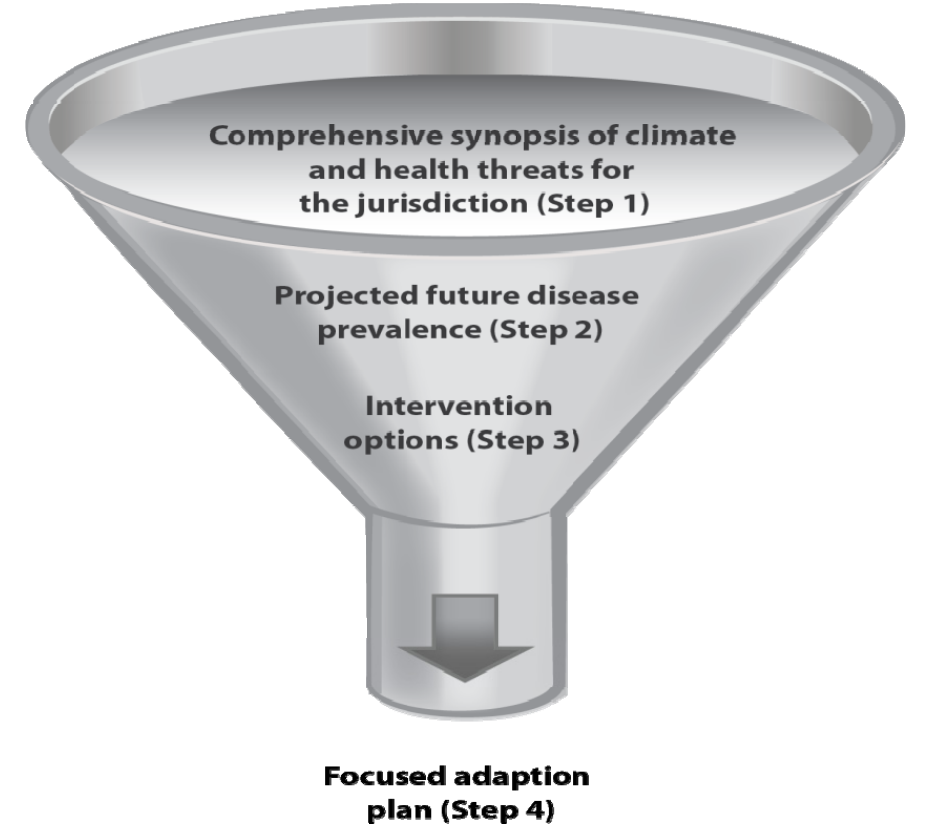
Figure 2. Prioritization of climate and health impacts and suitable